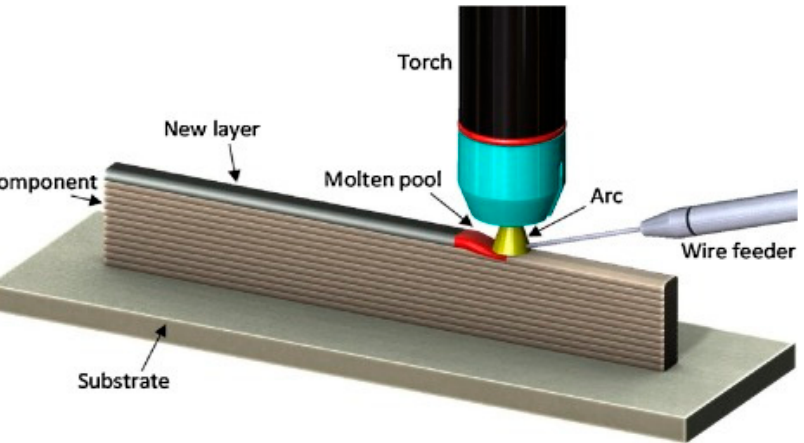
Figure 1. Illustrative diagram of WAAM process and Schematic representation of different zones in WAAM part, being MPB: melt pool border, MPZ: melt pool zone, and RM: remelted, HAZ: heat affected zone [27].